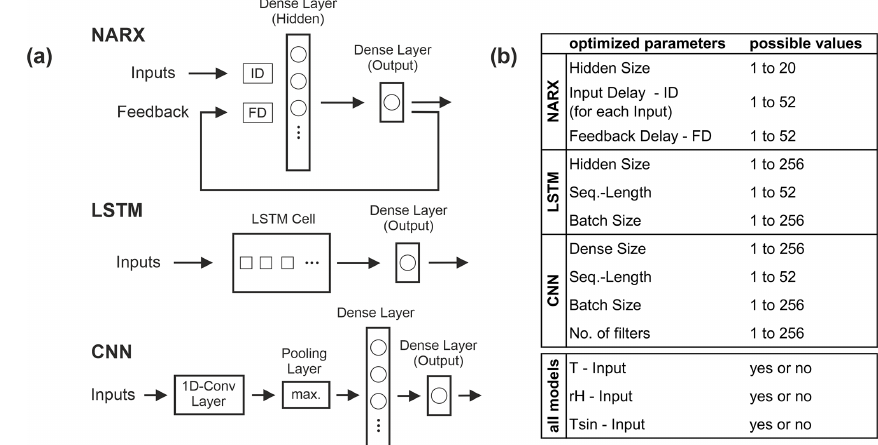
Figure 1. (a) Simplified schematic summary of the models and their structures used in this work. ID and FD are delays, circles in dense layers symbolize neurons, and squares within the LSTM cell represent the number of hidden units. (b) Hyperparameters (and inputs) of each model used to tune the models by using Bayesian optimization algorithm; the last column summarizes the optimization ranges for each parameter.